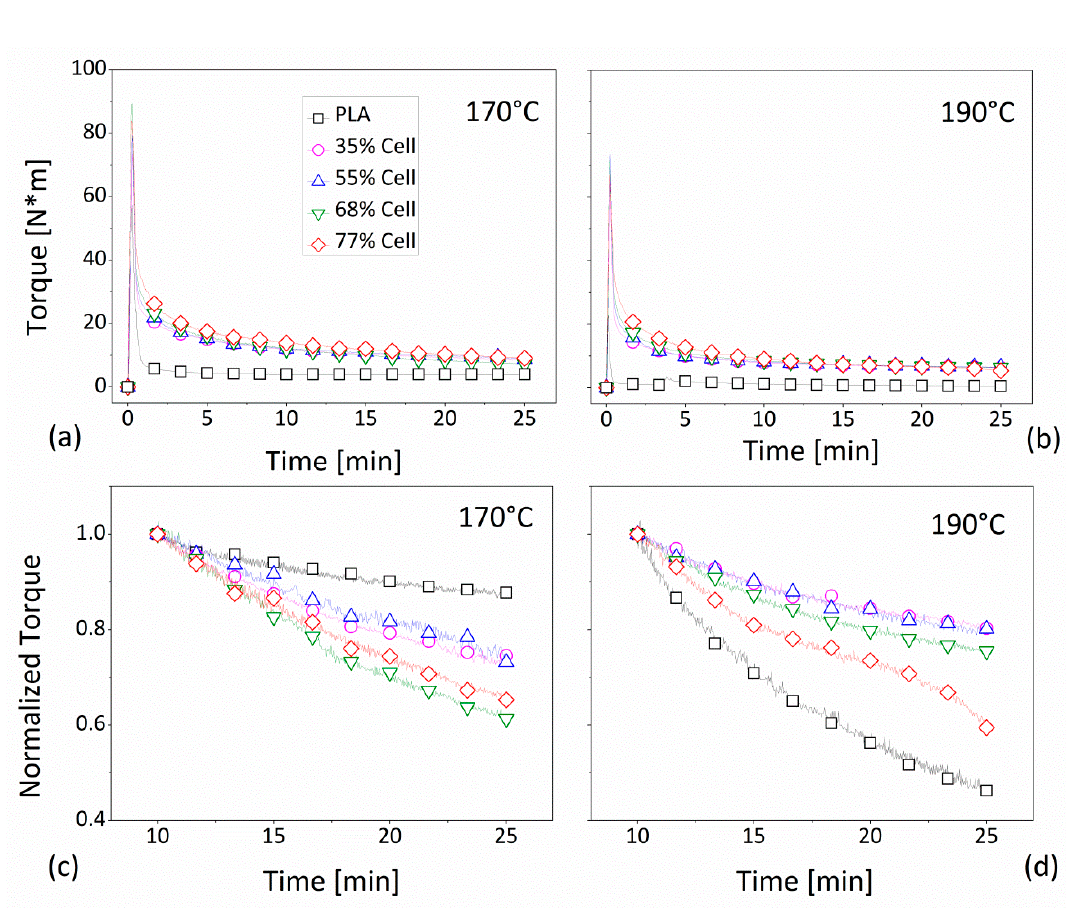
Figure 2. Torque versus mixing time, as measured during the melting of the PLA composites: ( a ) at a temperature of 170 °C; ( b ) at a temperature of 190 °C. The normalized torque versus the mixing time as measured during the melting of the PLA composites: ( c ) at a temperature of 170 °C; ( d ) at a temperature of 190 °C. Legend in Figure 2b–d as in Figure 2a.